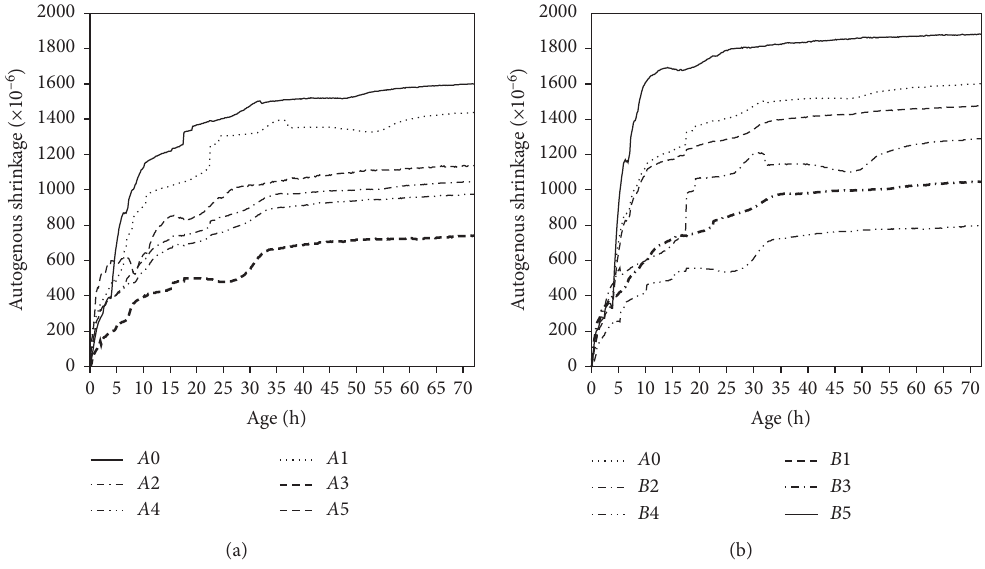
Figure 4: FC autogenous